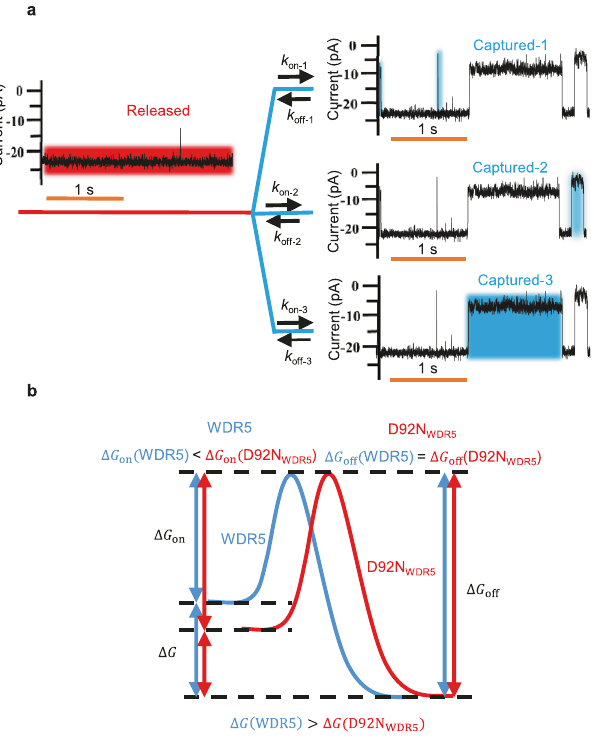
Fig. 6 Kinetic model of MLL4 Win -WDR5 interactions. a This model includes the open current substate, O on (highlighted in red), and the three protein recognition events, O off (highlighted in blue). b Model of the free energy landscape of MLL4 Win -WDR5 interactions for both WDR5 and D92N WDR5